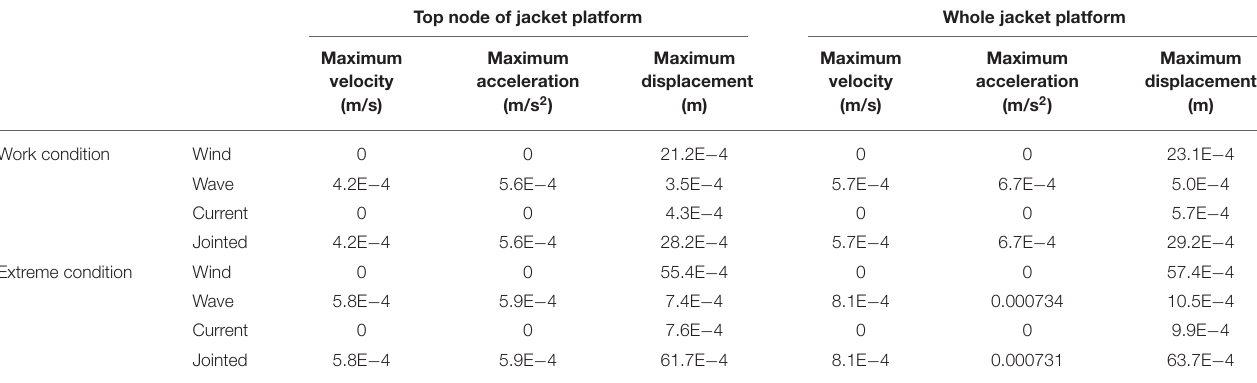
TABLE 1 | Dynamic responses under different load